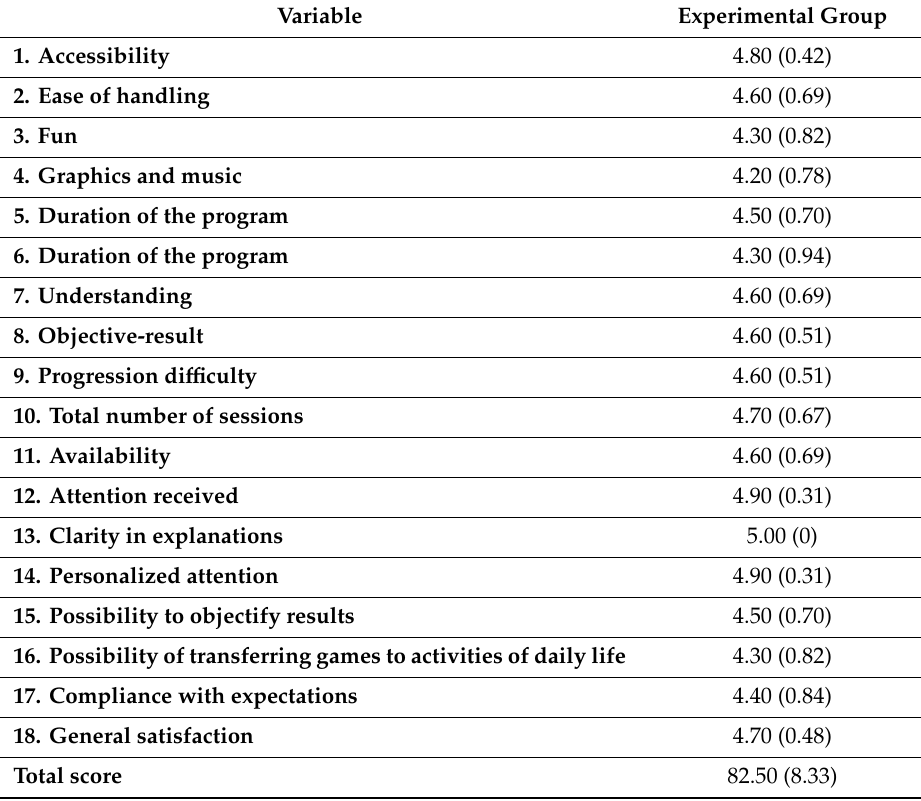
Table 6. Degree of satisfaction with the VR and videogames